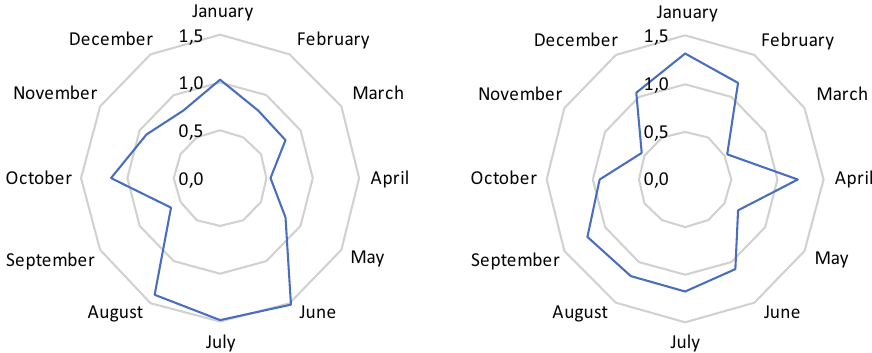
Figure 2. Seasonal indices of mortality among children aged 5-9 (left) and children aged 10-14 (right) in the Pokrovsky parish (1877-1897), both sexes. Source: author’s calculations based on parish